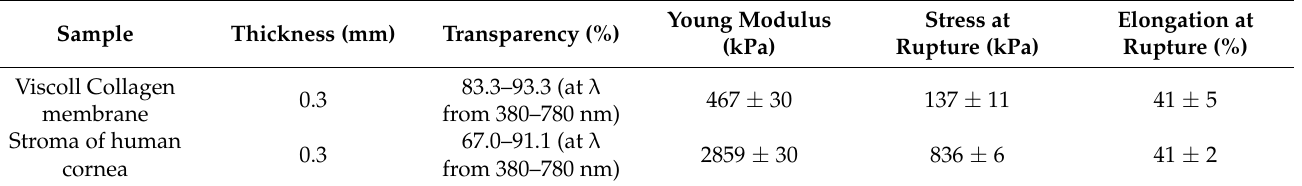
Table 1. Optical and mechanical properties of Viscoll collagen membrane made from 3% ( w / v ) collagen solution and stroma of the human cornea.